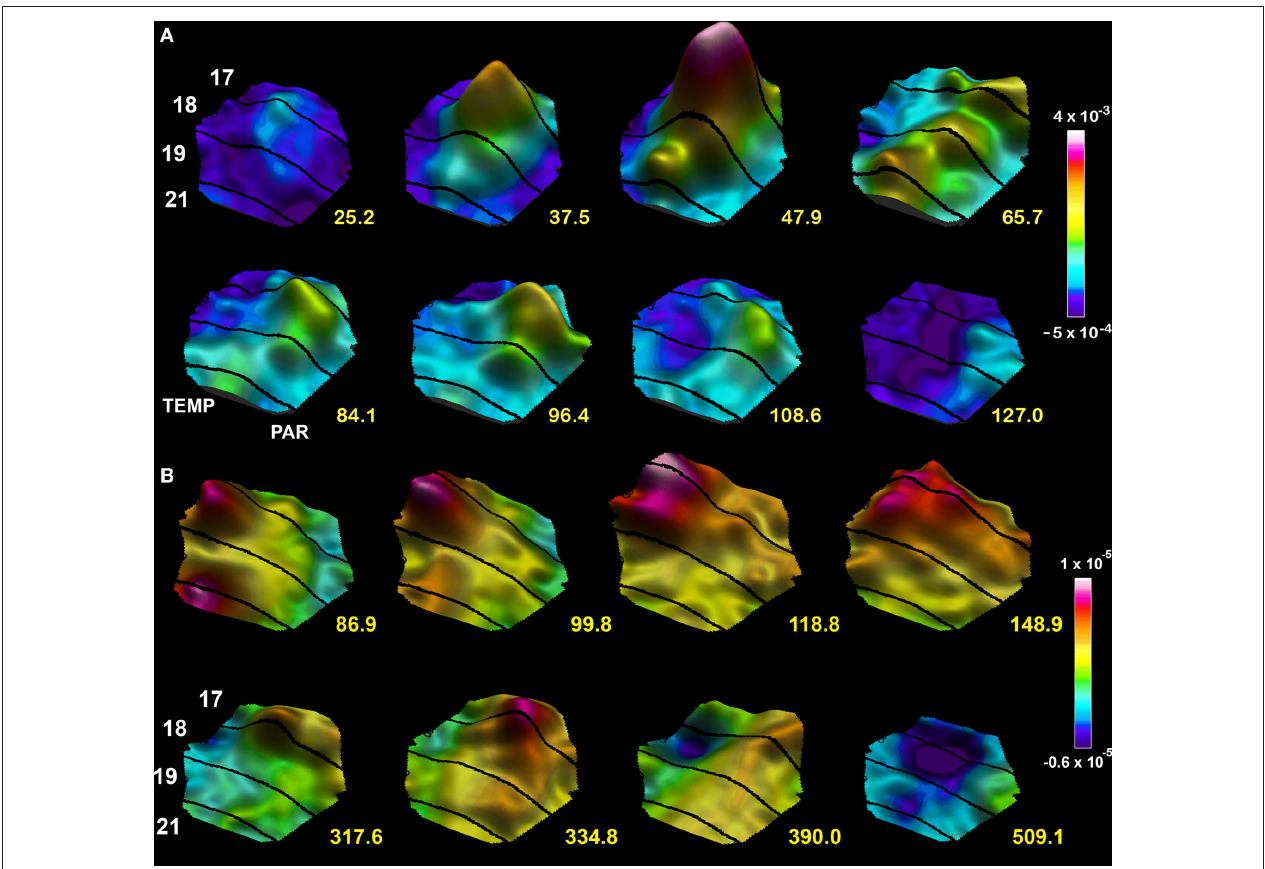
peripheral field of view. The mapping of the moving object enters the Figure 7 | Spatio-temporal dynamics snapshots of the d V /d t in response m measurement area at 86.9 ms. FB from the 19/21 mapping site towards the to a moving bar 1 × 2 ° . (A) Appearing in the center of field of view at time 17/18 mapping site 99.8–118 ms, computation of an excitation in the cortical 0 ms. Note the FF excitation establishing a moving bump at the area 19/21 direction of motion 148.9 ms, progress towards the cortical zone mapping the border, the lateral spreading excitation from both mapping sites, the FB directed center of field of view 317–334.8 ms associated with a new FF excitation towards the cortical direction of motion 65.7–84.1 ms and the resulting towards the 19/21 border. As the object moves on the lateral spreading inhibition excitation in the direction of cortical motion along the 17/18 border 96.4 ms, the appears at the sites where the object was mapped along the 17/18 lateral inhibition spreading behind the excitations mapping the moving object cytoarchitectural 108.6–127 ms. (B) Moving object appearing 10.5 ° from the center in the